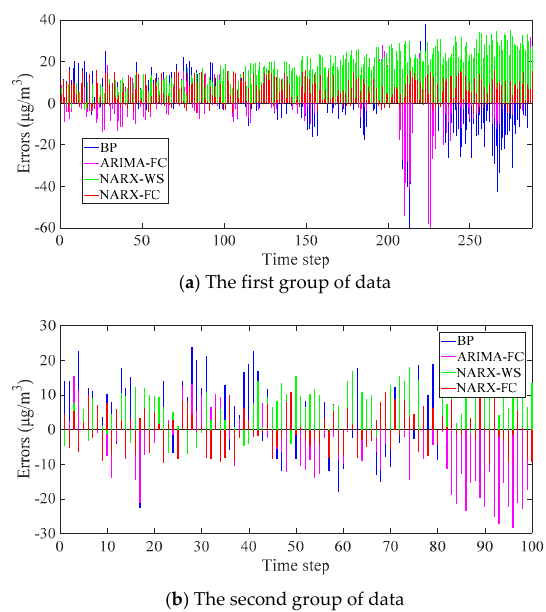
Figure 8. Errors of the prediction results in different methods. Table 3. Error evaluation indicator of the prediction results of SO 2.